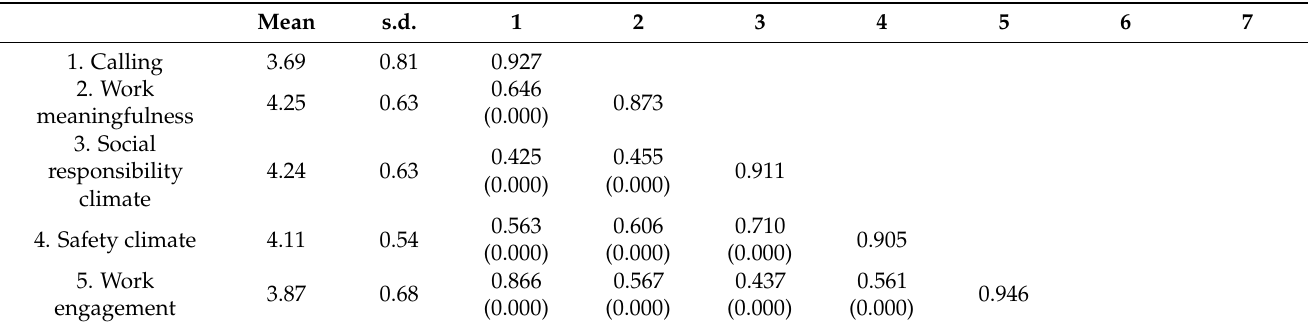
Table 2. Means, standard deviations, correlations, and internal consistency